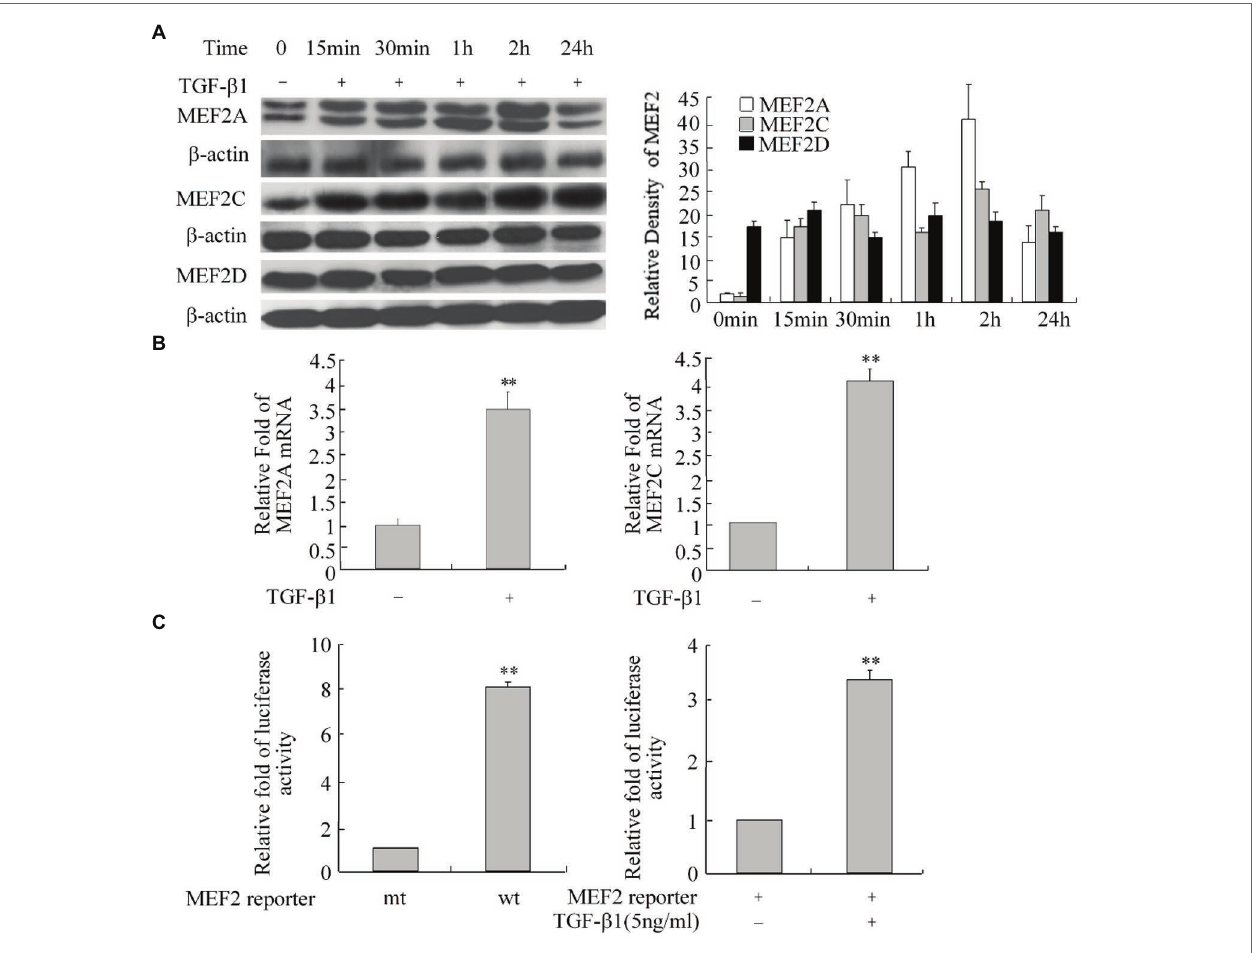
FIGURE 3 | Increase in MEF2 expression during TGF- β 1-induced activation of H-HSCs. (A) Regulation of MEF2 protein expression by TGF- β 1. The levels of MEF2 proteins and β -actin at different time points following TGF- β 1 (10 ng/ml) treatment were determined by western blot on day 7 in primary H-HSCs. The right graph represents quantification ( n = 5). (B) TGF- β 1-induced increase of MEF2 mRNA expression. Primary H-HSCs were treated with TGF- β 1 for 2 h at day 7 in culture. MEF2 mRNAs was determined by RT-qPCR ( n = 3, ** p < 0.01 vs. without TGF- β 1-induction). (C) Increase in MEF2-dependent gene transactivation activity after TGF- β 1 treatment. Left panel, primary H-HSCs on day 5 in culture were transfected with a vector for the MEF2 luciferase reporter for 48 h. Right panel, primary H-HSCs on day 5 in culture were transfected with a vector for the MEF2 luciferase reporter for 46 h and treated with TGF- β 1 (5 ng/ml) during